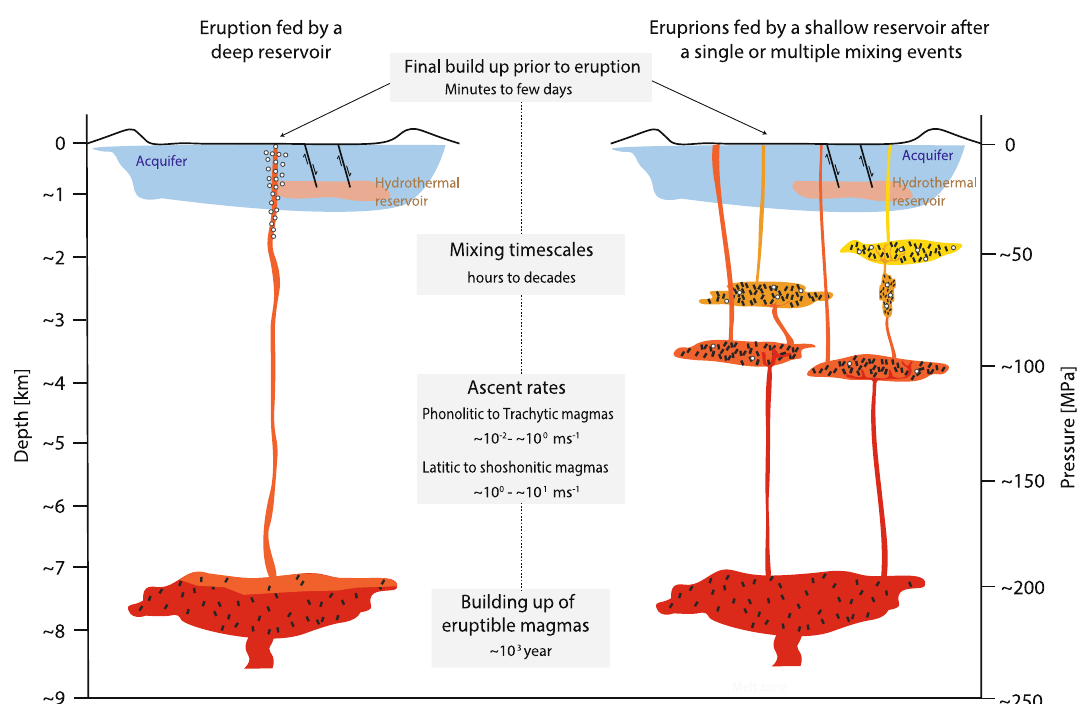
Fig. 5 Analogies and differences between two possible models for plumbing system of CFC. The two scenarios can be seen as end-members of an intermediate, variable actual arrangement of the plumbing